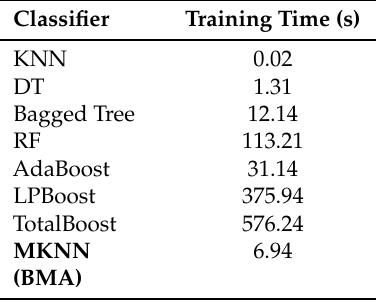
Table 3. Computation time training